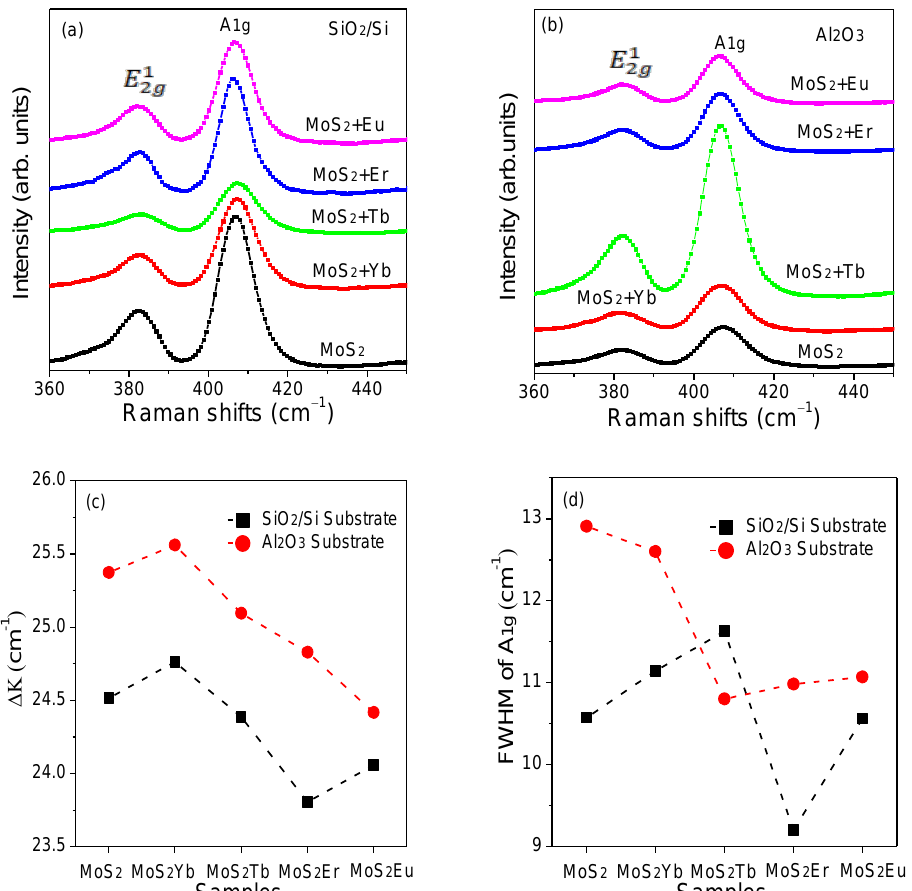
Figure 2. ( a , b ) The Raman spectra of the MoS 2 and RE-doped MoS 2 samples deposited on SiO 2 /Si and Al 2 O 3 substrates, respectively, after 550 ◦ C annealing in Ar + H 2 gas ambience. ( c ) The separations (ΔK) between the 𝐸 2𝑔1 and the A 1g peaks for the samples. ( d ) The FWHMs of the A 1g peaks of the samples deposited on the Al 2 O 3 and the SiO 2 /Si substrates.